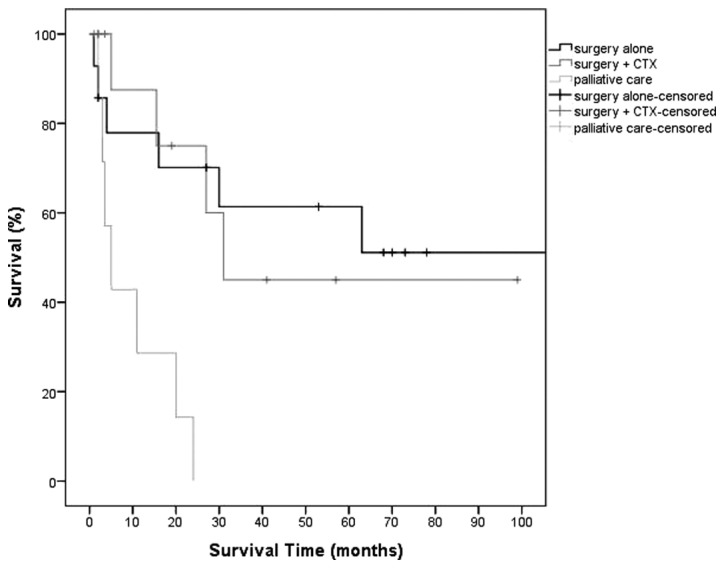
Survival curves with respect to performed therapy. CTX, chemotherapy.